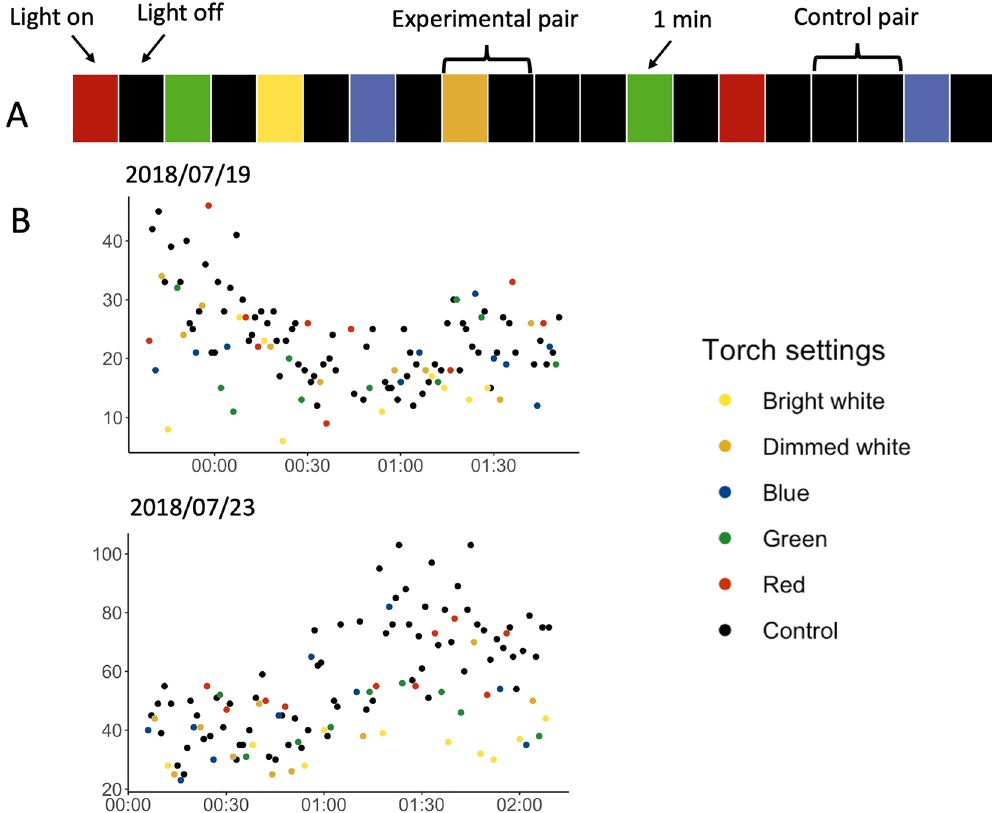
Figure 2. ( A ) Visualisation of an example of treatment series of the spectra experiment, with consecutive 1-min segments (rectangles on the figure) with the torch on and off. Each experimental pair (‘light-on’, ‘light-off’) has a coloured segment corresponding to one of five different settings (‘red’, ‘green’, ‘blue’, ‘dimmed white’ and ‘bright white’) followed by a black segment representing the light off. Two black segments indicate a control pair (‘light- off’, ‘light-off’). ( B ) Two example days of the spectra experiment undertaken at the Farm (19th July 2018 starting at 23:40BST) and on the Neck (23rd July 2018 at 00:07BST). They show the count of birds per minute against time. Different colours of dots represent various